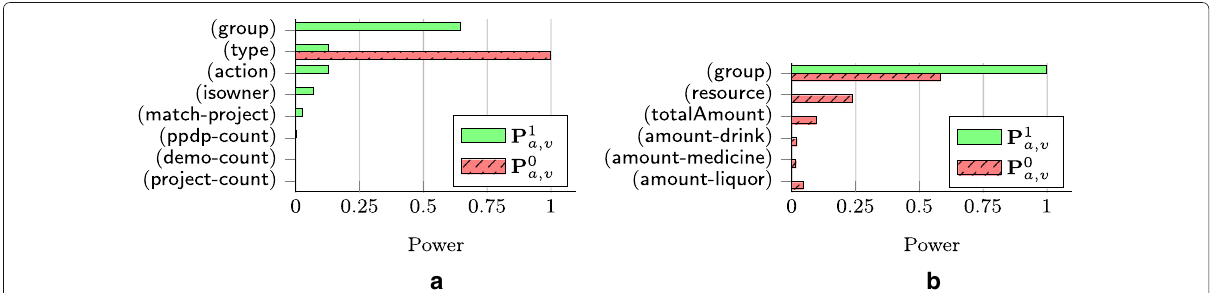
a b Fig. 5 Power distribution for the SAFAX (10) and KMarket (10) policies aggregated per attribute: the plain green bar indicate the power for the decision 1 for each attribute (as the aggregation of the power for all values for that attribute), while the patterned red bars indicate the power for the decision 0. a SAFAX (10). b KMarket